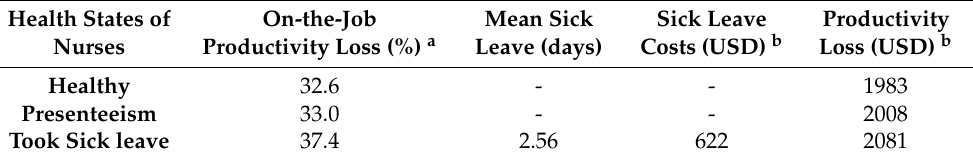
Table 5. Monthly estimates on productivity loss per nurse employee by